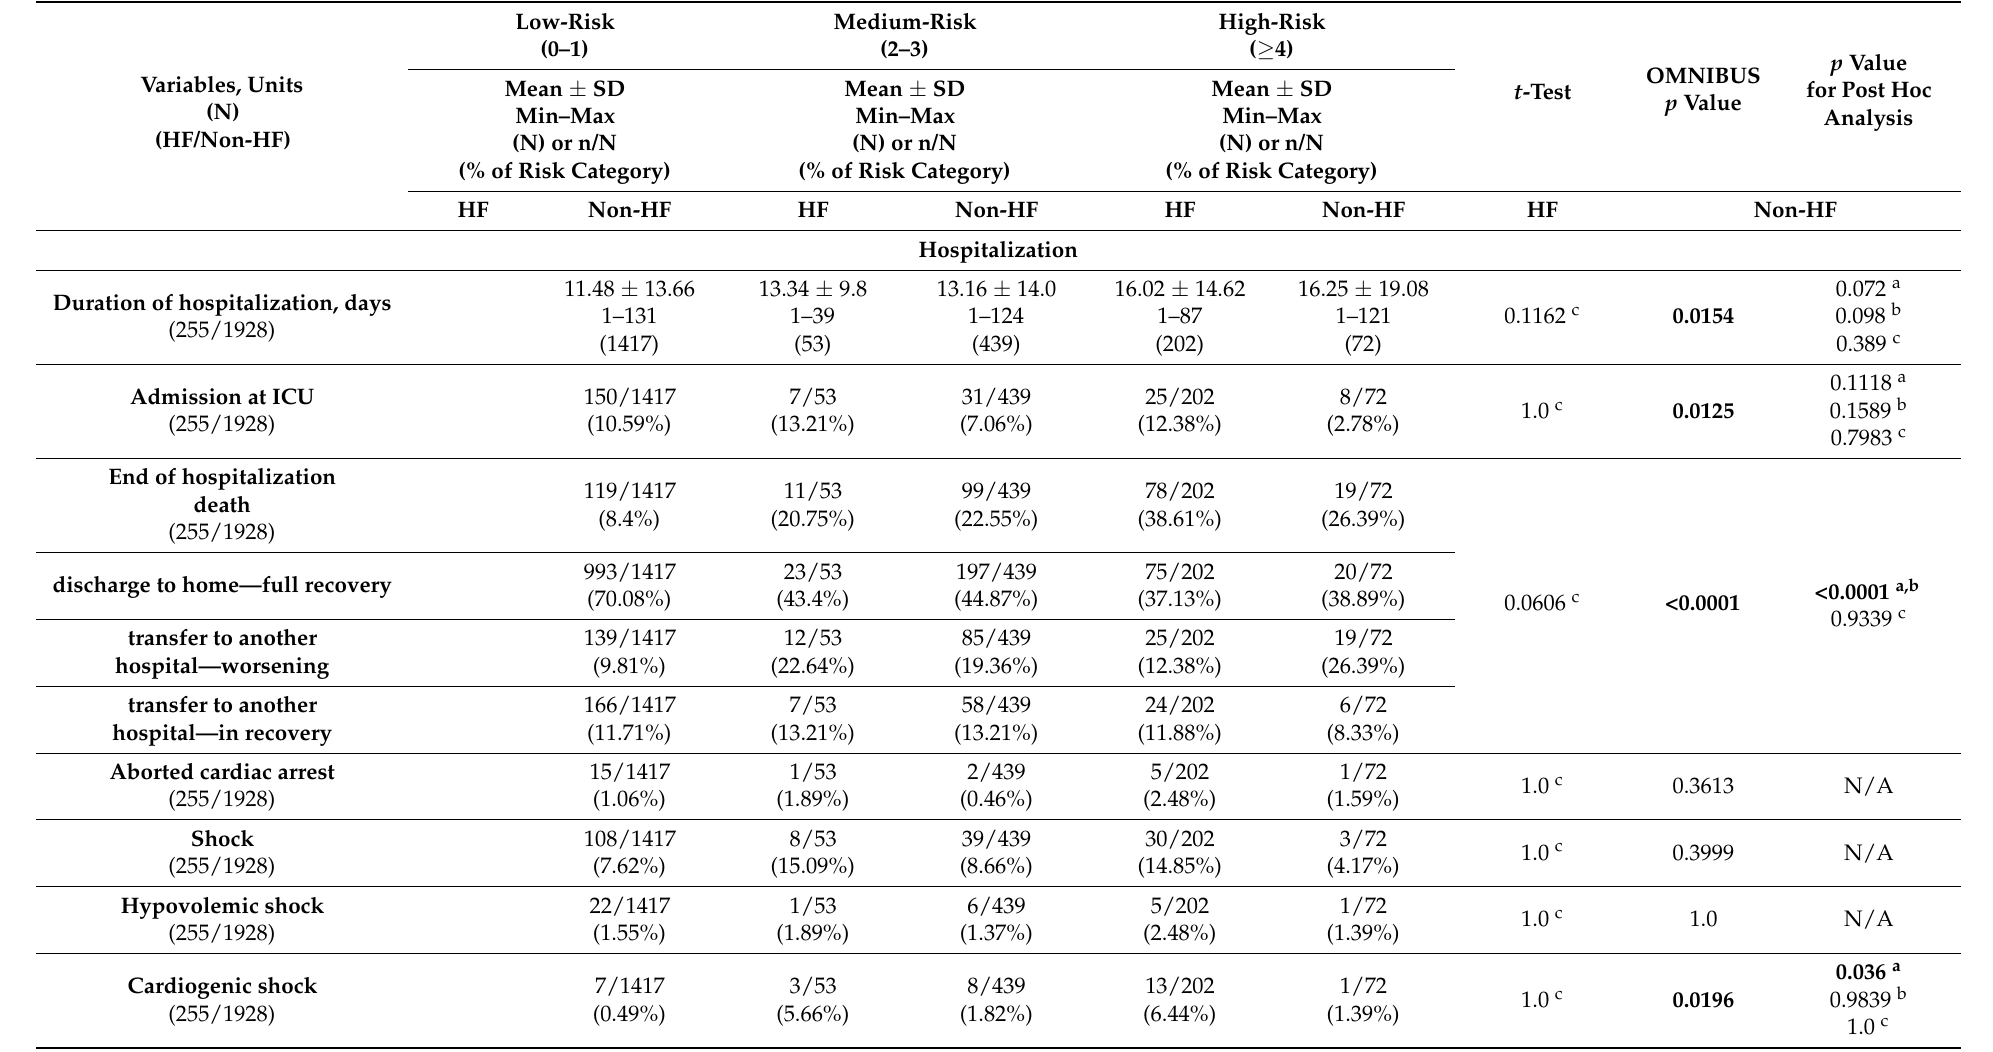
Table 9. Clinical non-fatal events and hospitalization outcomes in the C 2 HEST risk strata in heart failure and non-failure